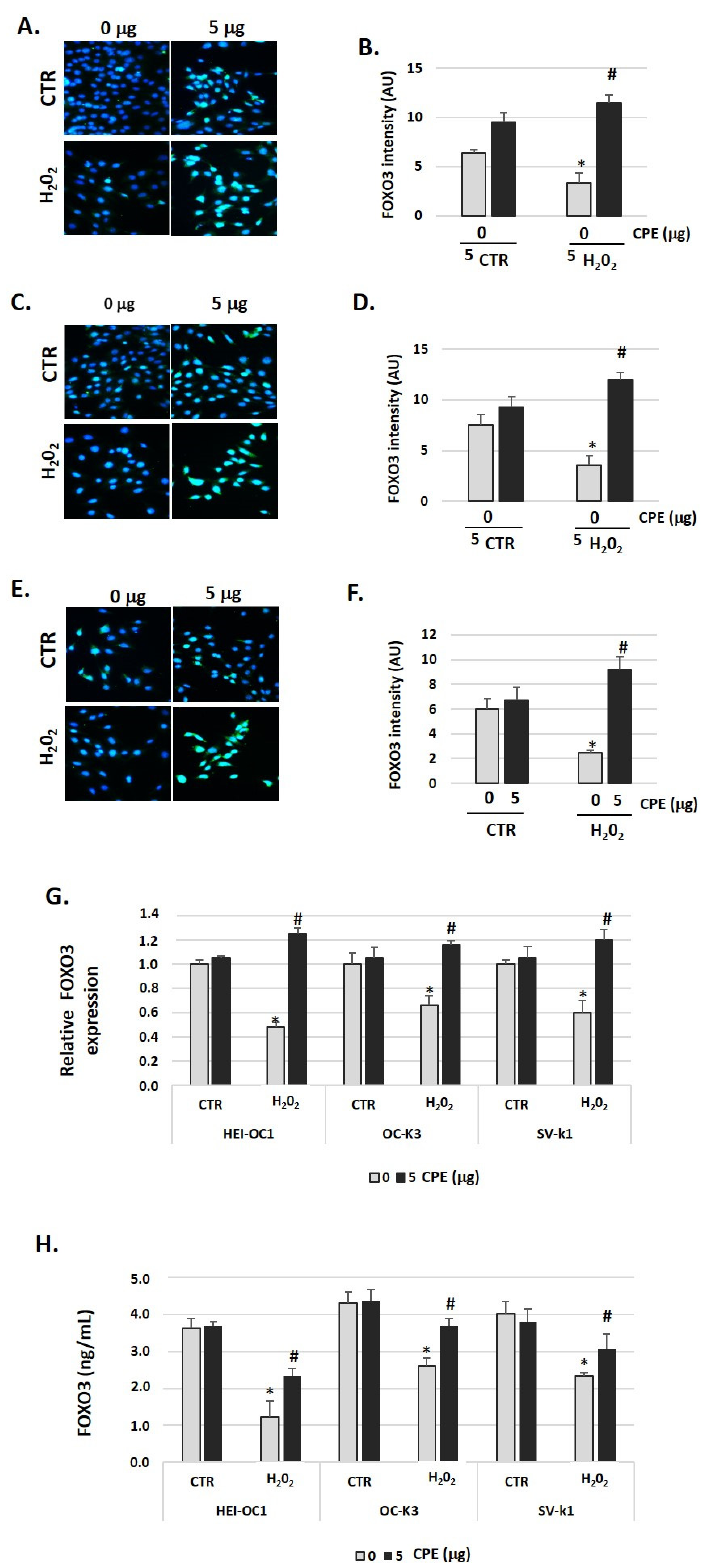
Figure 7. Cocoa increase expression of FOXO3 in senescence cells . Characteristic fluorescence images of staining for FOXO3 in ( A ) HEI-OC1, ( C ) OC-k3, and ( E ) SV-k1 cells post-treatments. Nuclei were detected in blue fluorescence by DAPI, and FOXO3 immunoreactivity was labeled in green fluorescence; ( B , D , F ) Graphs represents the immunofluorescence intensity analyzed by Image J for